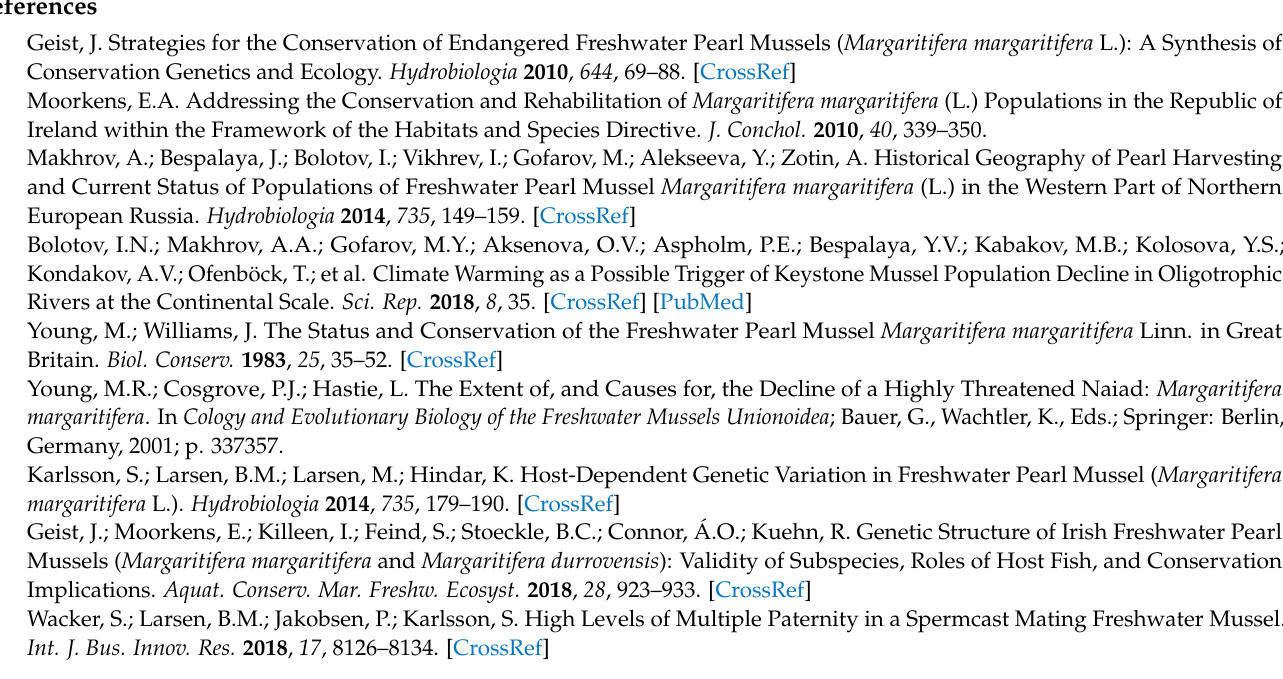
fish. Table S3: Matrix of COI haplotype frequencies in populations of Margaritifera margaritifera. Table S4: Loading values of haplotypes to PC1 and PC2 obtained using matrix of haplotype frequencies in Margaritifera margaritifera populations. PCA under the “basin” factor. Table S5: Mismatch distribution verification tests for spatial population expansion and size population expansion assumptions for the WS group of Margaritifera margaritifera populations. Statistically significant values are marked in bold ( p < 0.05). Refs [67–78] are cited in Supplement